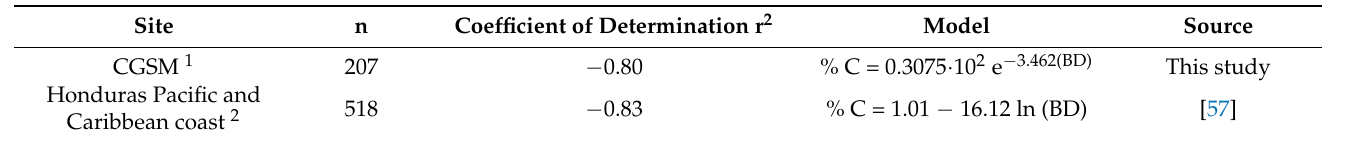
Table 5. Relationship between bulk density-BD (g cm − 3 ) and soil carbon SC (%) (calculated via dry combustion) for mangrove soil samples. n = number of